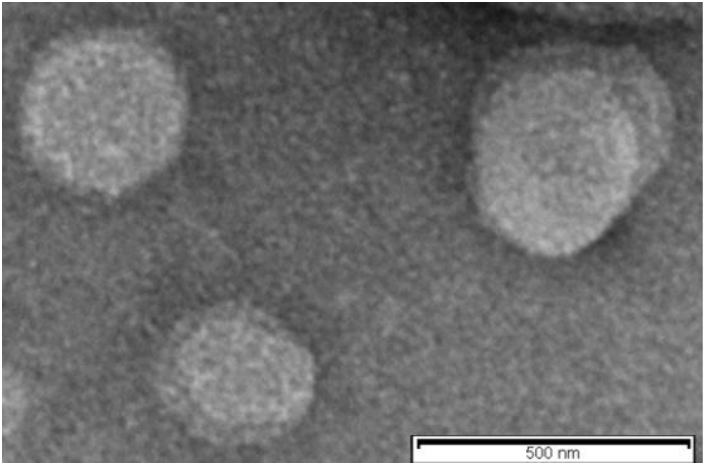
Figure 4. Transmission electron microscopy (TEM) of reconstituted SLN (sample G 1 ). Differential Scanning Calorimetry (DSC)